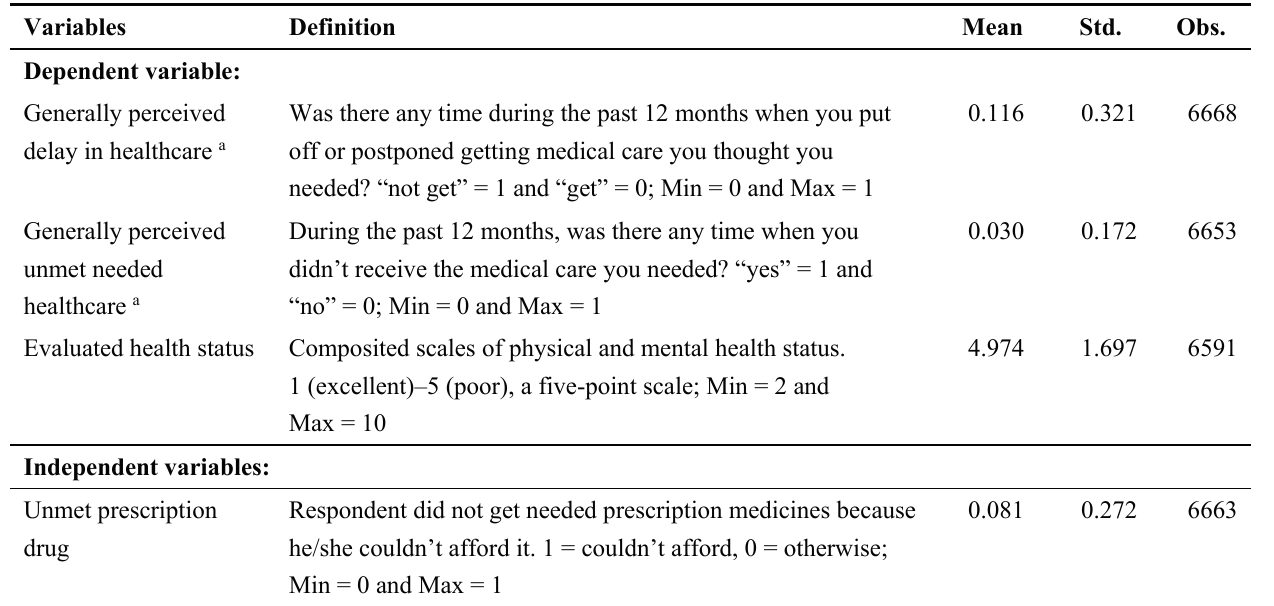
Table 2. Definitions and characteristics of delayed healthcare, unmet needs needed healthcare, evaluated health status, and others (aged